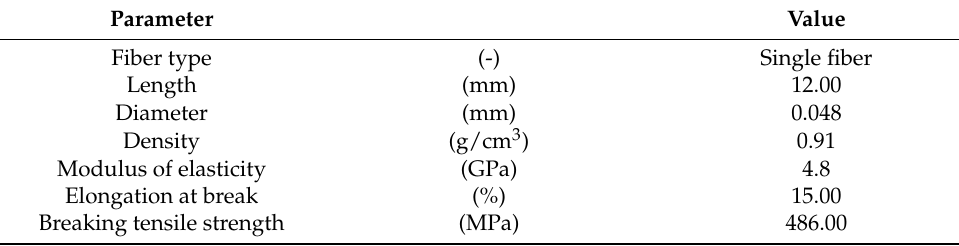
Table 3. Parameters of the polypropylene